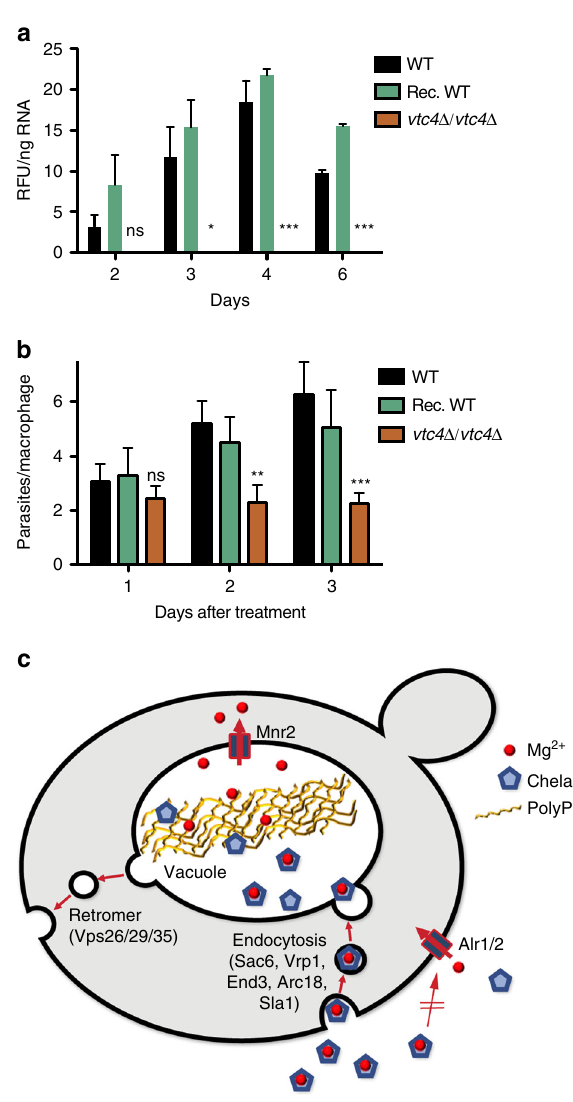
Fig. 6 PolyP and growth of Leishmania major in macrophages. a PolyP levels during promastigote growth. Promastigotes of wild-type, a double-knockout of LmVTC4 ( vtc4 Δ / vtc4 Δ ) and of the double-knockout reconstituted with a wild-type allele of LmVTC4 (rec. WT) were inoculated in M199 medium. They were analyzed for their polyP content at the indicated times after inoculation. Day 4 corresponds to logarithmic growth, day 6 to stationary phase. b Proliferation inside macrophages. Bone-marrow-derived macrophages were infected with late stationary phase promastigotes. Microscopy pictures were taken 24, 48, and 72 h after infection and the number of amastigotes was counted in > 100 macrophages per cell line. a , b The results represent mean ± SD. Statistical differences were evaluated using Student ’ s t test, comparing vtc4 Δ /vtc4 Δ with wild-type cells at each time point from 4 independent experiments: ns,